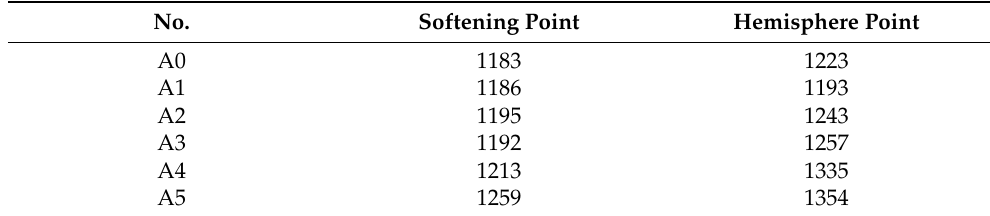
Table 2. The relationship between melting temperature of synthetic slag and Cr 2 O 3 content, ◦ C. No. Softening Point Hemisphere Point